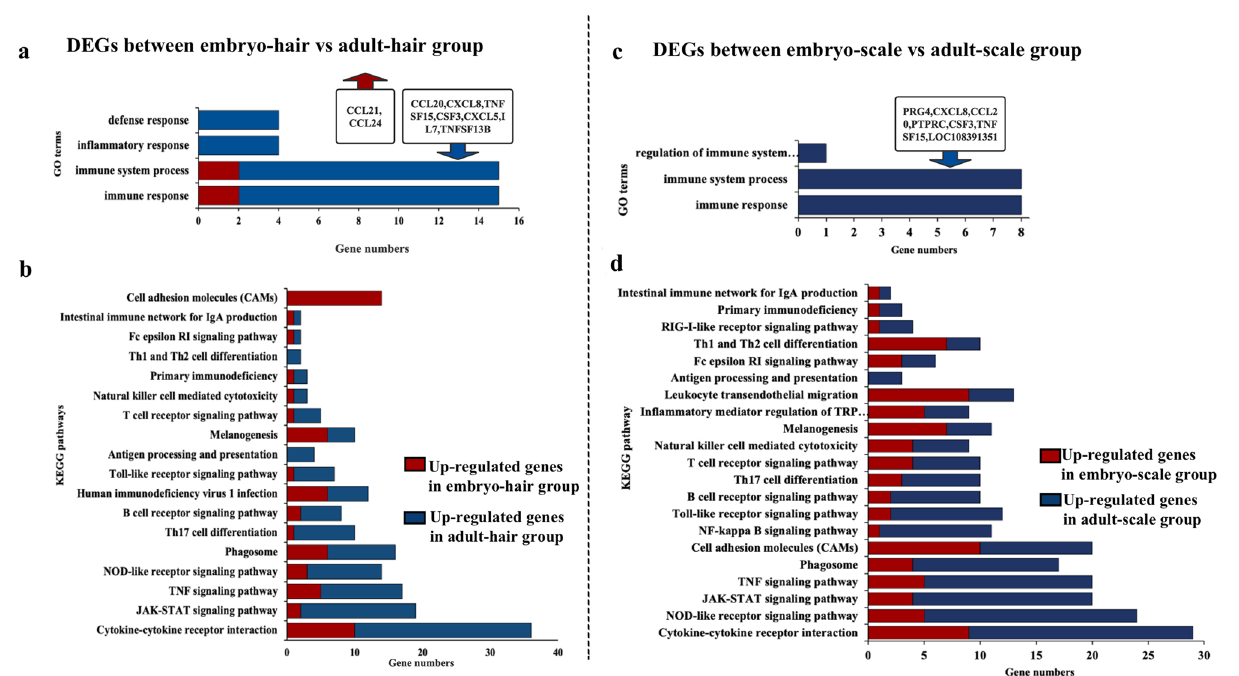
Figure 7. GO and KEGG enrichment analysis of DEGs related to immunity between embryo and adult skin tissue. ( a ) GO terms DEGs between embryo-hair vs adult-hair group in GO enrichment; ( b ) KEGG signalling pathways related to immunity with DEGs between embryo-hair vs adult-hair group; ( c ) GO terms DEGs between embryo-scale vs adult-scale group in GO enrichment; ( d ) KEGG signalling pathways related to immunity with DEGs between embryo-scale vs adult-scale